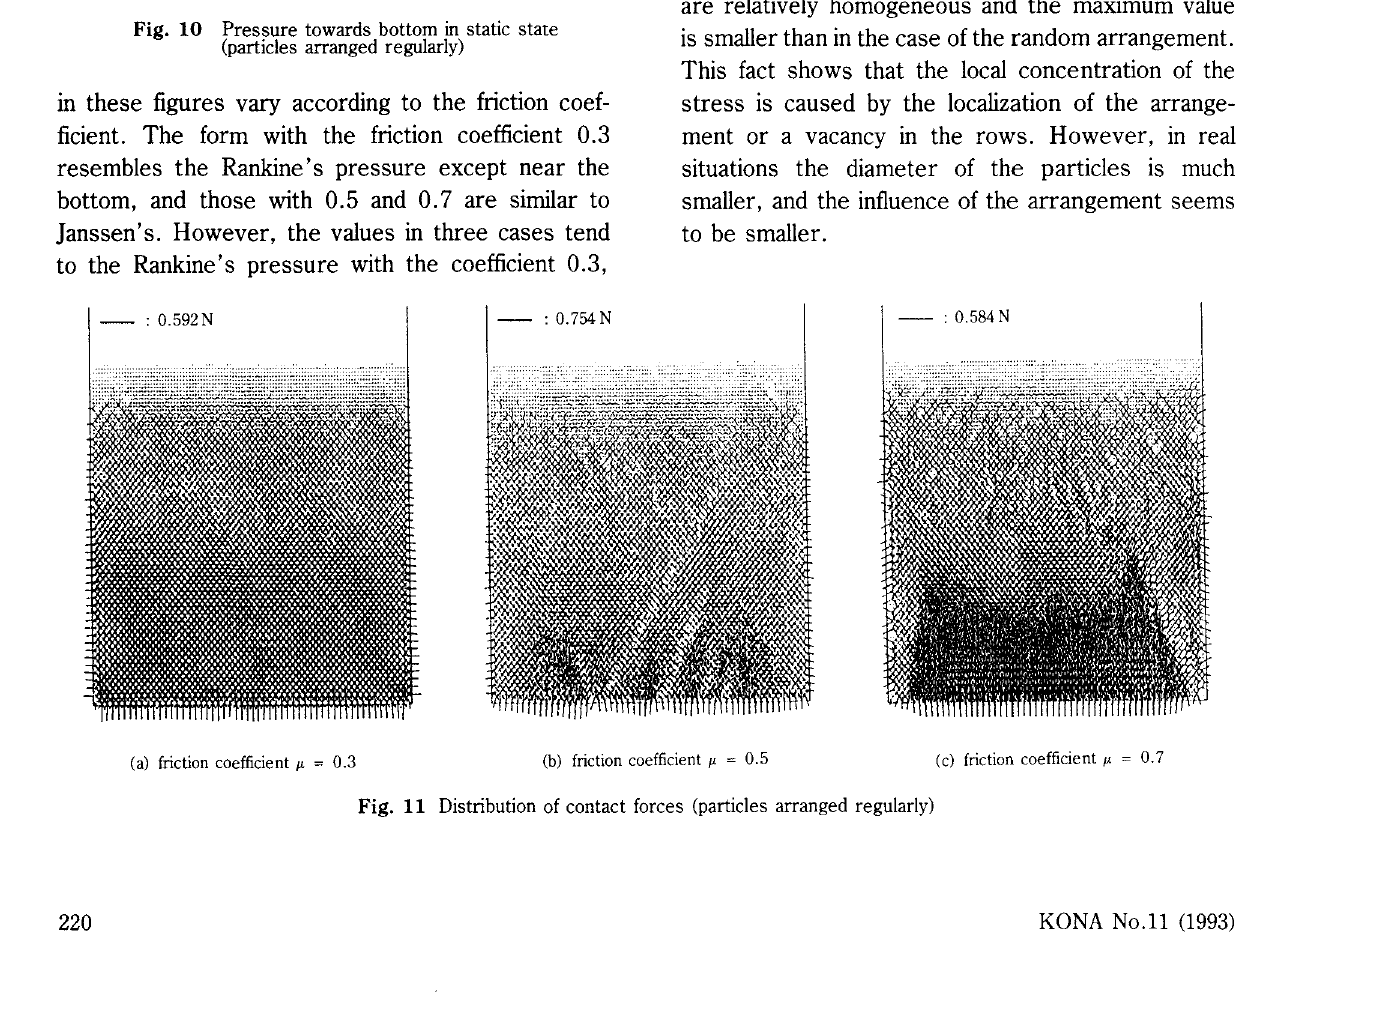
Fig. 9 Pressure towards side walls in static state (particles arranged regularly)